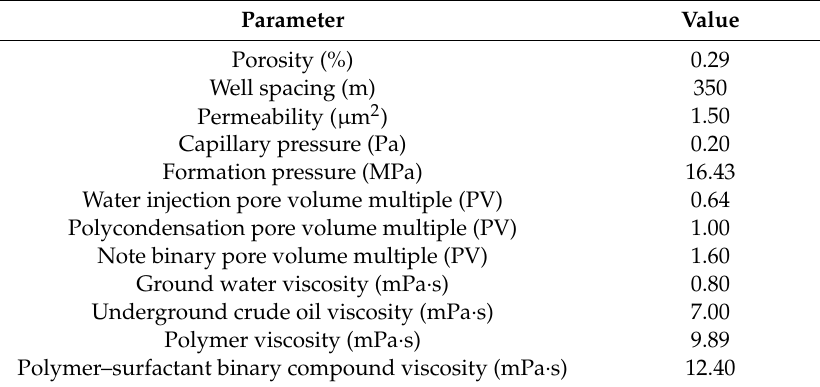
Table 1. Basic data of the JZ9-3